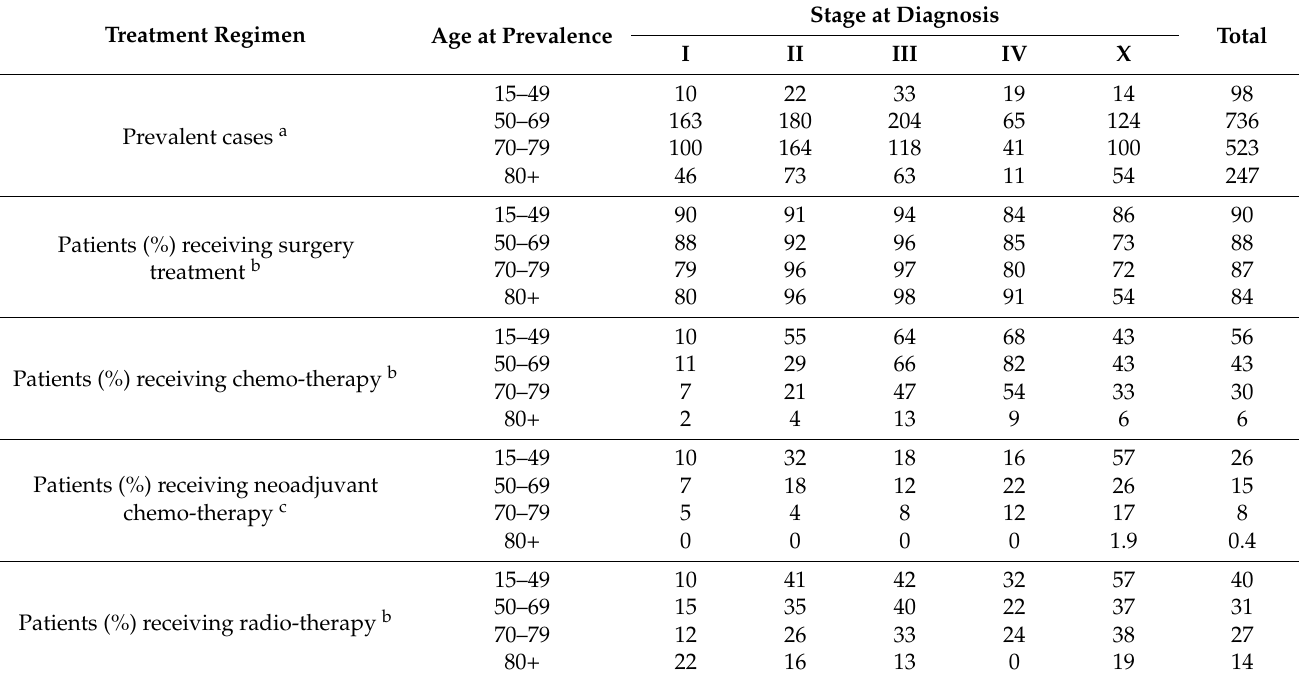
Table 5. Prevalent cases in initial phase and treatment regimen by stage at diagnosis and age at prevalence. Treatment Regimen Age at